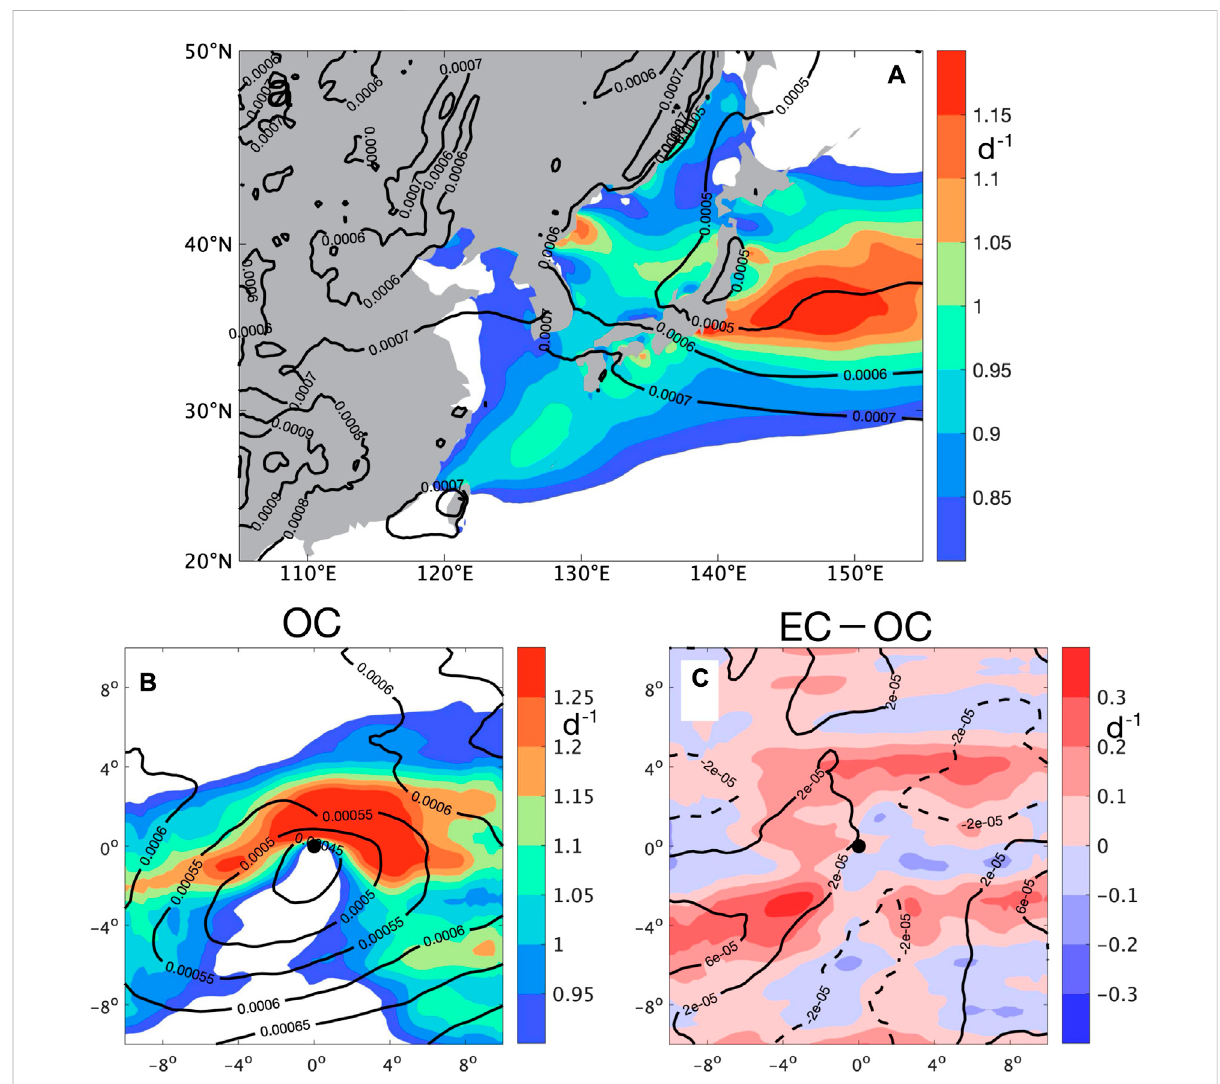
FIGURE 5 Low-level baroclinicity and static stability over East Asia (A) and around the OC center (B) , and the difference between ECs and OCs (C) . ShadingsdenoteEGR,andcontoursdenote Γ (unit:K Pa − 1 ).Solid/dashedlinesin (C) denoteaverage Γ forECslarger/smallerthanOCs.Bothvariables are retrieved from “ daily values ” between 850 and 700 hPa. For (A) , “ daily values ” are the potential temperatures and wind velocities averaged during 00 – 23UTCofeachday,andEGRand Γ areaveragedwithin10winters.For (B – C) , “ dailyvalues ” areaveragedinrelativegeographiccoordinates within the 20 ° ×20 ° box around the center during the fi rst 24 h for each cyclone, and EGR and Γ are averaged among all OCs or